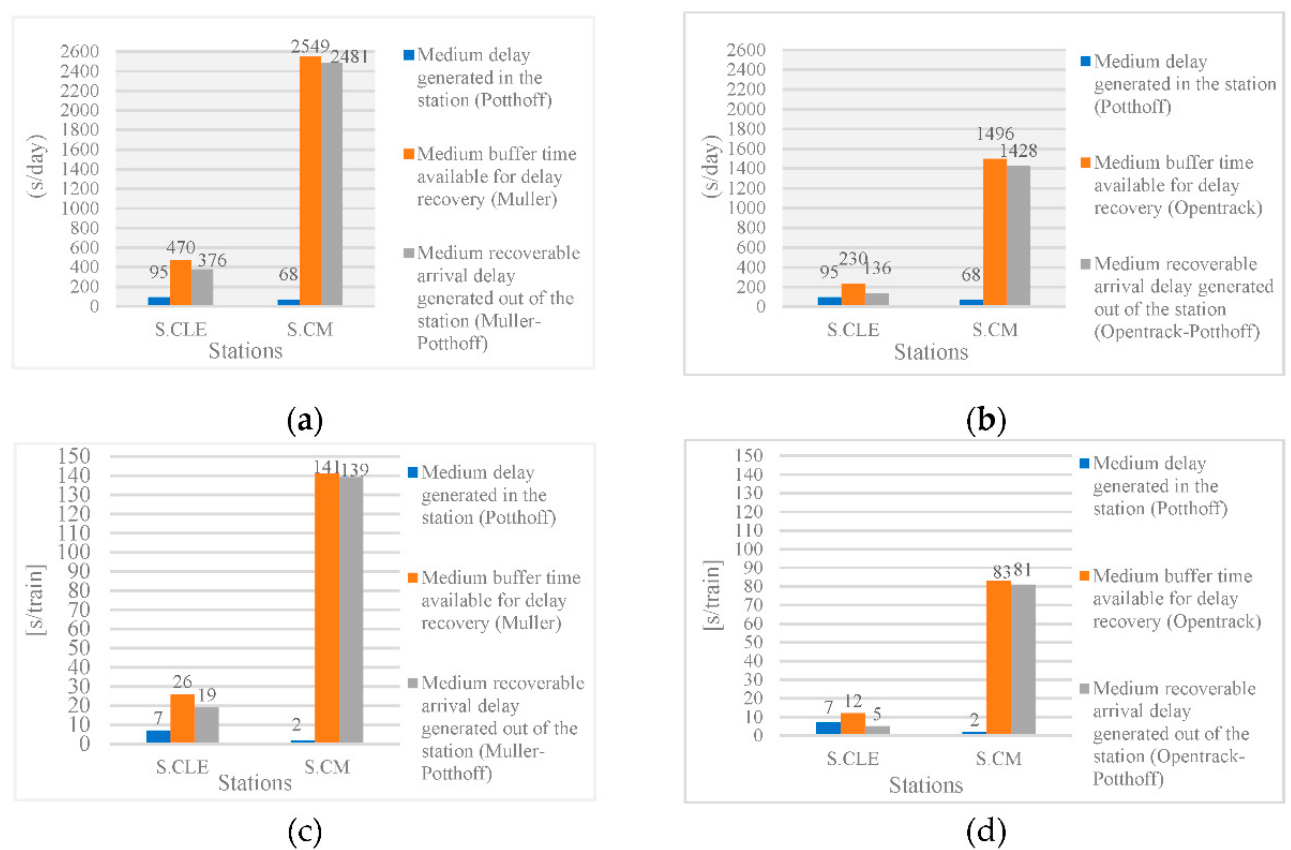
Figure 6. Delays, buffer times, and delay recovery potentials for Trieste Centrale and Trieste Campo Marzio stations by analytical and simulation methods listed as: ( a ) Result of Müller-Potthoff methods in seconds per day; ( b ) Result of Opentrack-Potthoff methods in seconds per day; ( c ) Result of Müller-Potthoff methods in seconds per train; ( d ) Result of Opentrack-Potthoff methods in seconds per train.